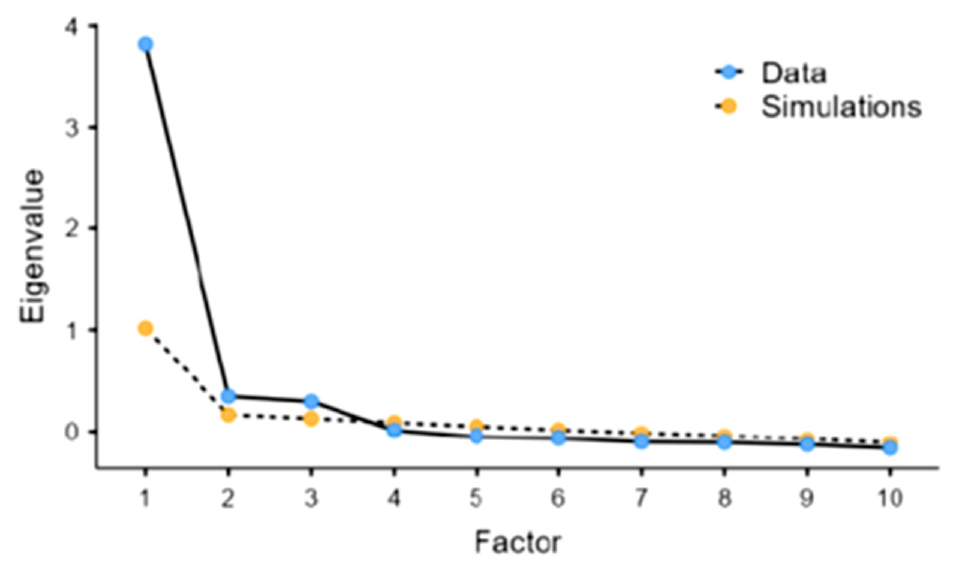
Figure 1. Scree plot for 10 items of the BOS ( n = 739). The three components account for 22.9%, 20.3%, and 20% of the variance, resulting in 63.2% of the total variance (Table 5). The KMO value was 0.908, and Bartlett’s test of sphericity was significant ( p < 0.001), which indicated that the dataset was adequately sampled and that factor analysis of the data was appropriate. Table 5. Principal component analysis of the BOS ( n = 739). We tested the three-component model including 10 items to evaluate how well the three domains were combined to identify the underlying construct of the BOS using CFA. Figure 2 presents the factor correlations and loading.